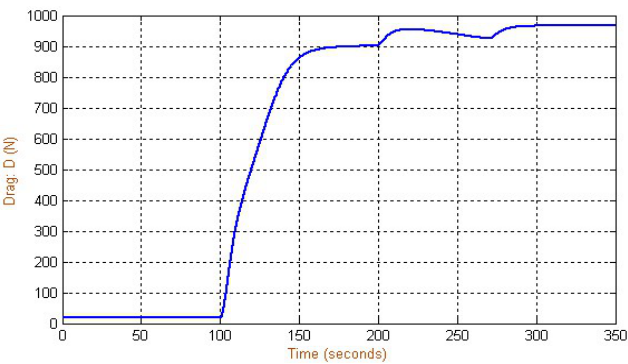
Figure 24. Drag versus time.